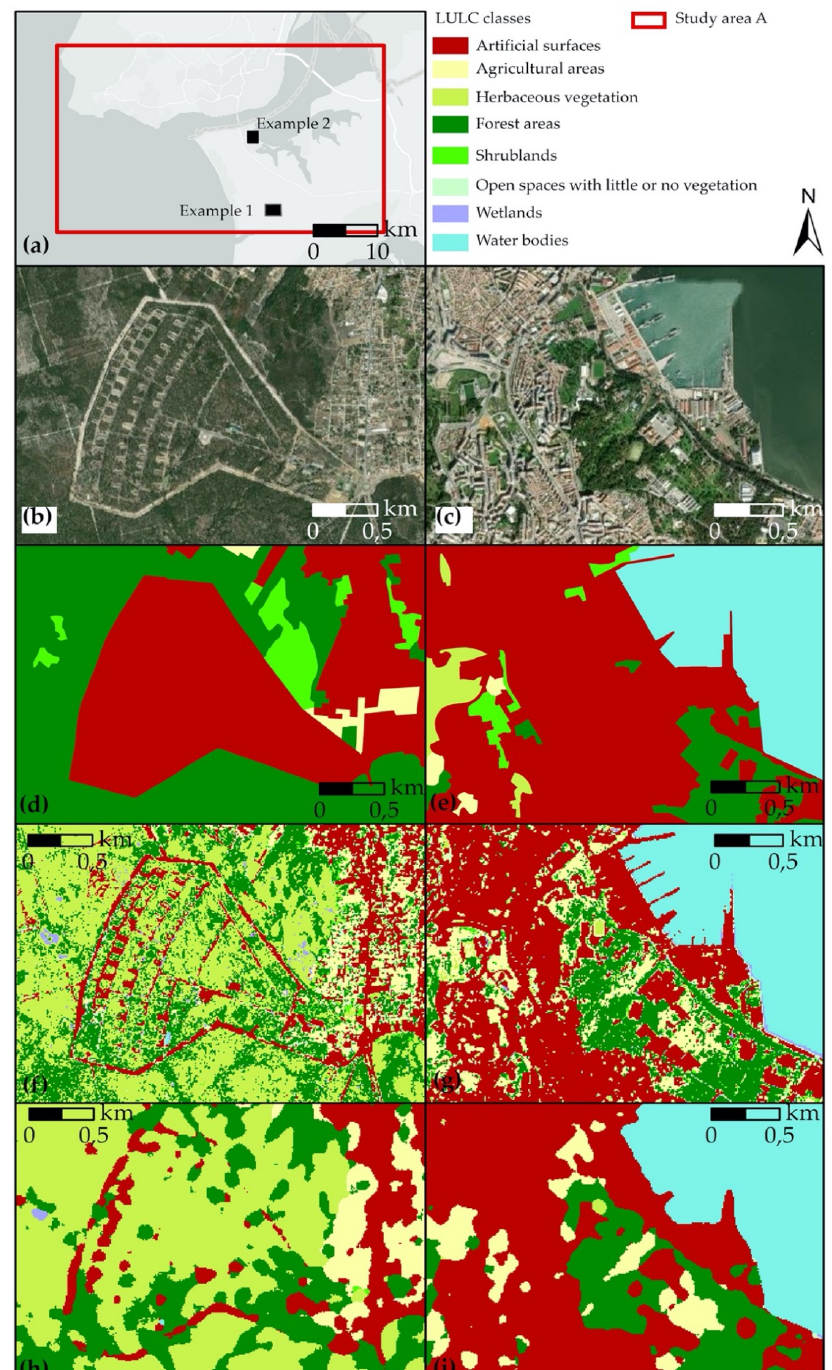
Figure 14. Detailed data for two example zones 1 and 2 in the study area A. ( a ) Shows the location of both regions in study area A, ( b , c ) show very high resolution imagery for, respectively, example regions 1 and 2; ( d , e ) show the COS derived reference map; ( f , g ) show the classification results obtained with the training data extracted from TD2; ( h , i ) show the generalized maps corresponding to ( f , g ) for, respectively, example zones 1 and 2.